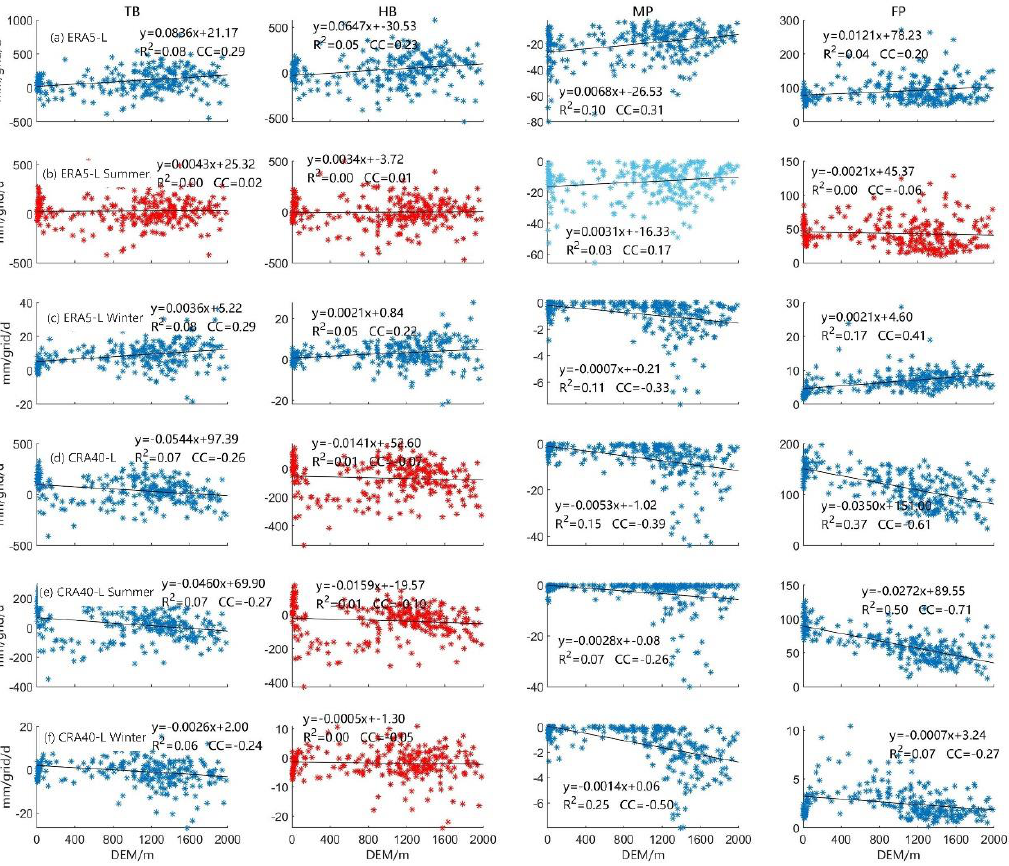
Figure 12. ( a – f ) Correlation between elevation and error components, namely, TB , HB , MP , and FP